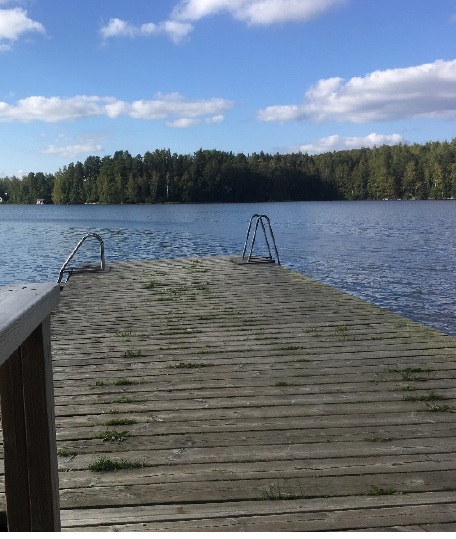
Figure 1. The typical view from a lakeside cottage plot in Finland (Photo courtesy of Hüseyin Emre Ilgın).